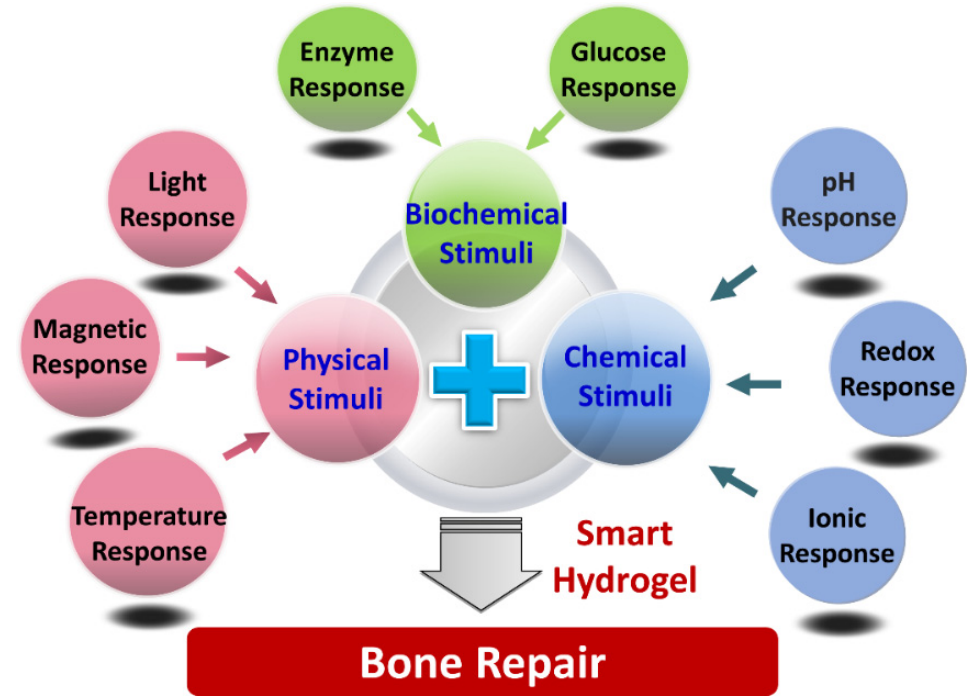
Figure 1. Schematic illustration of different types of smart hydrogels for bone